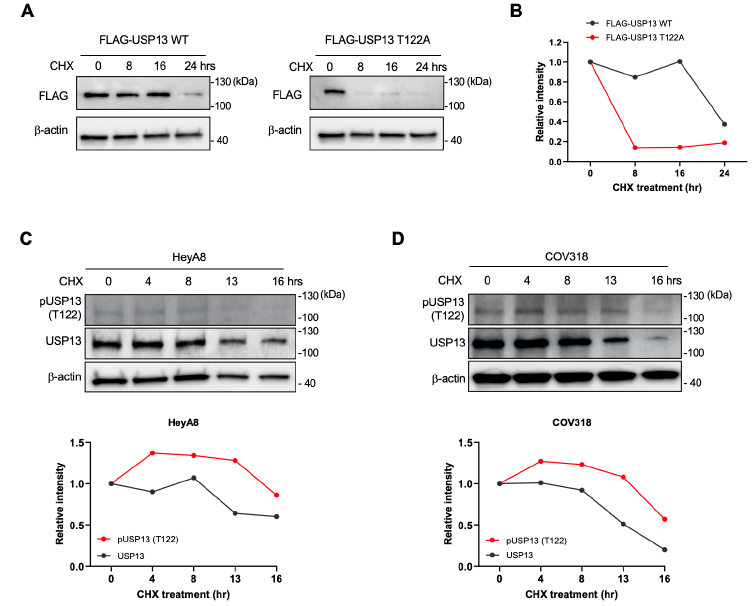
Figure 6. CK2-mediated phosphorylation affects USP13 stability. ( A ) Immunoblot analysis of HEK293T cells transfected with wild-type USP13 (left) or phospho-mutant USP13 (T122A) (right) followed by CHX (100 µg/mL) treatment for indicated times. ( B ) Quantification of the band intensi- ties in the (A). Band intensity was normalized to the β -actin. ( C , D ) The stability of total USP13 and pT122 USP13 was measured in ovarian cancer cells. Hey8A ( C ) or COV318 ( D ) were treated with CHX (100 µg/mL) for indicated times. The protein level was examined by western blotting (top) and quantified in the graph (bottom).